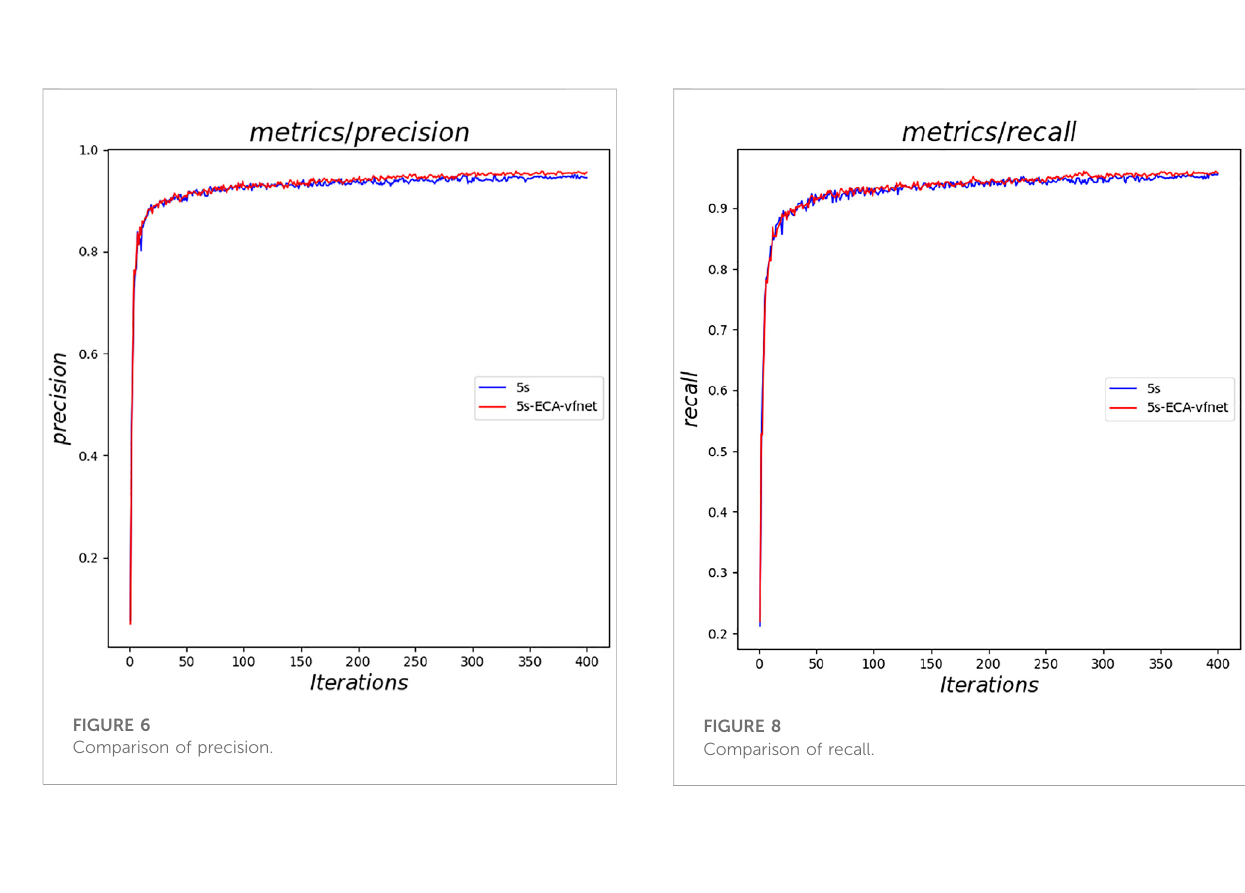
FIGURE 5 Curve of the loss function value with the number of training rounds.